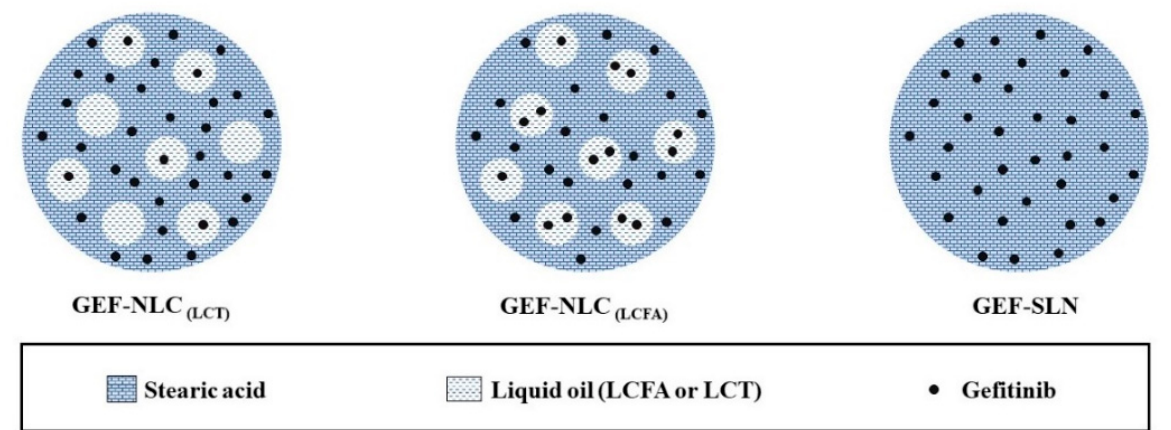
Figure 9. Schematic diagram of lipid core distribution of SA, LCT, LCFA, and GEF within GEF- NLC (LCT) , GEF-NLC (LCFA) , and GEF-SLN. LCT showed limited GEF solubility compared to LCFA.